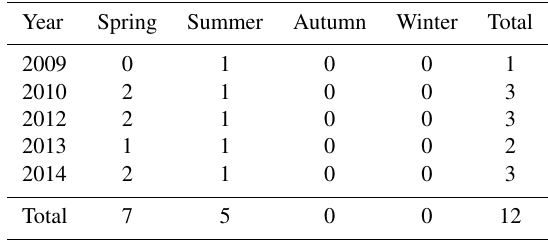
Table 7. Floods events recorded in Hanlinqiao hydrological station from 2009 to